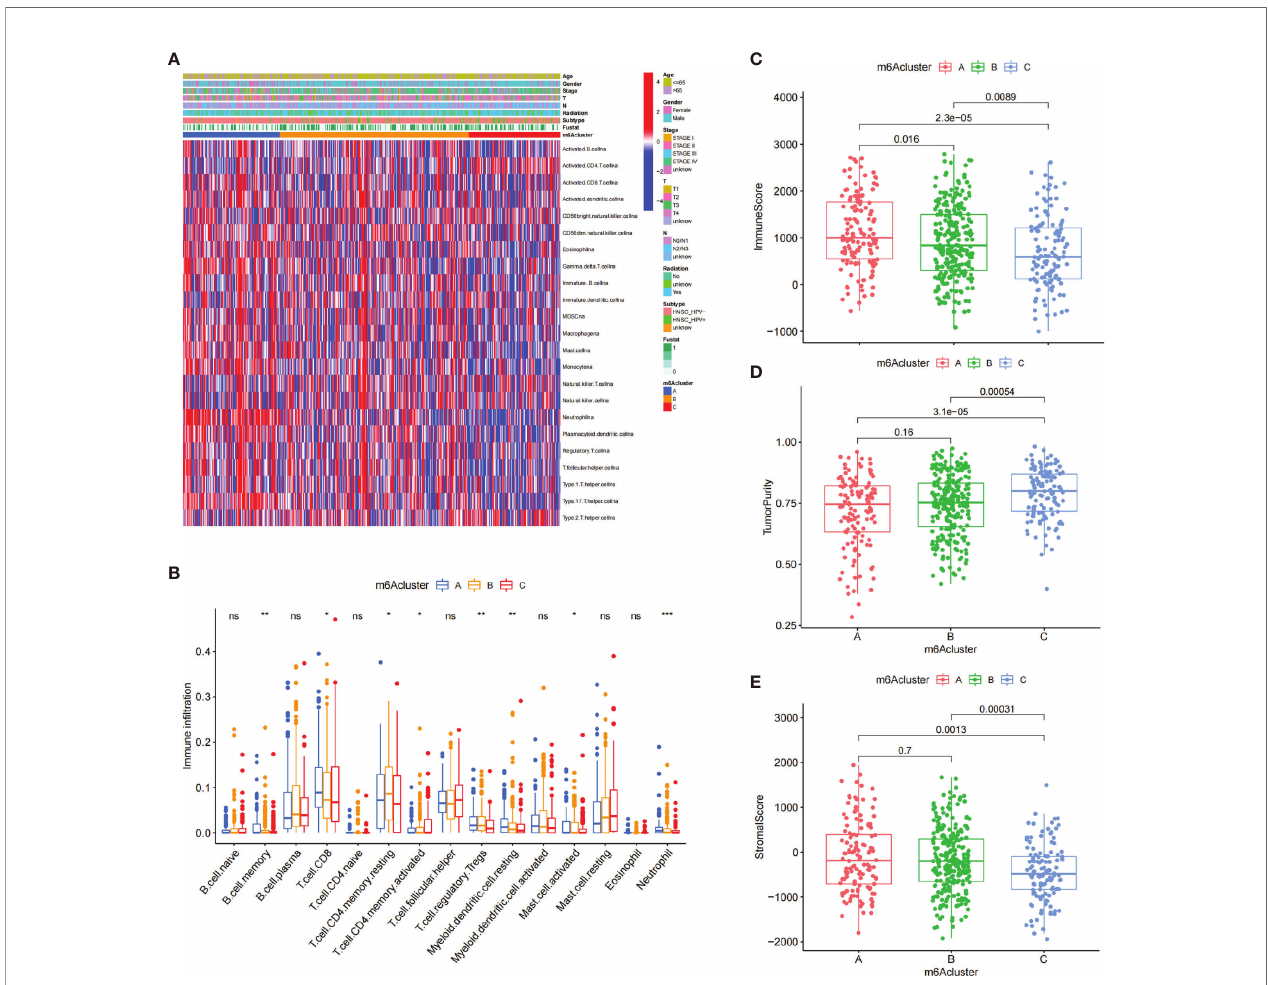
FIGURE 3 | The characteristics of TIME in three m 6 A clusters. (A) The heatmap showed the result of the consensus clustering in the TCGA cohort. Clinical information included age, gender, survival status, HPV subtypes, radiation, and stage. (B) The in fi ltration of immune cells in the three m 6 A clusters using the CIBERSORT. * p < 0.05; ** p < 0.01; *** p < 0.001. (C – E) The analysis of the immune score (C) , tumor purity (D) , and stromal score (E) among three m 6 A clusters. ns, no signi fi